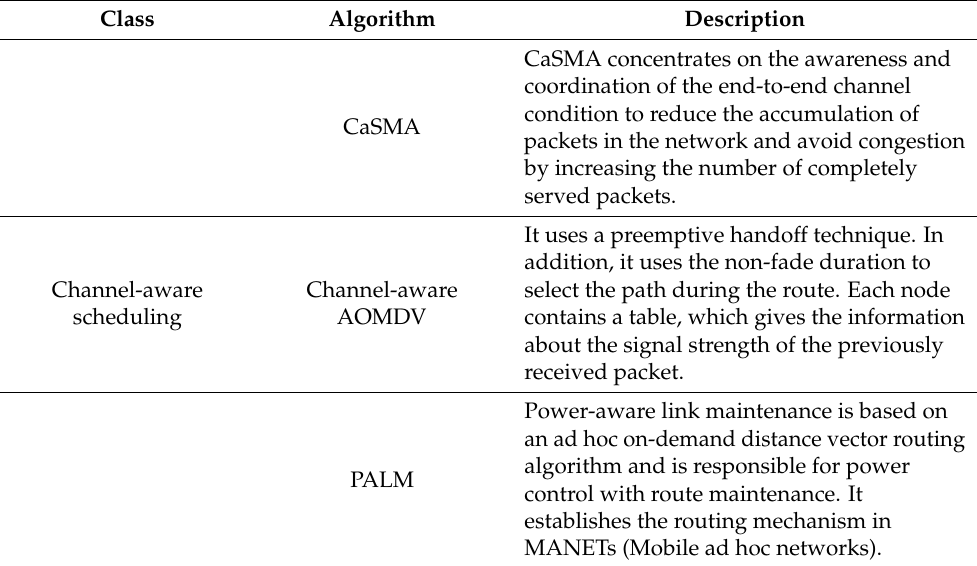
Table 2. Class of channel-aware scheduling algorithms in mobile ad hoc